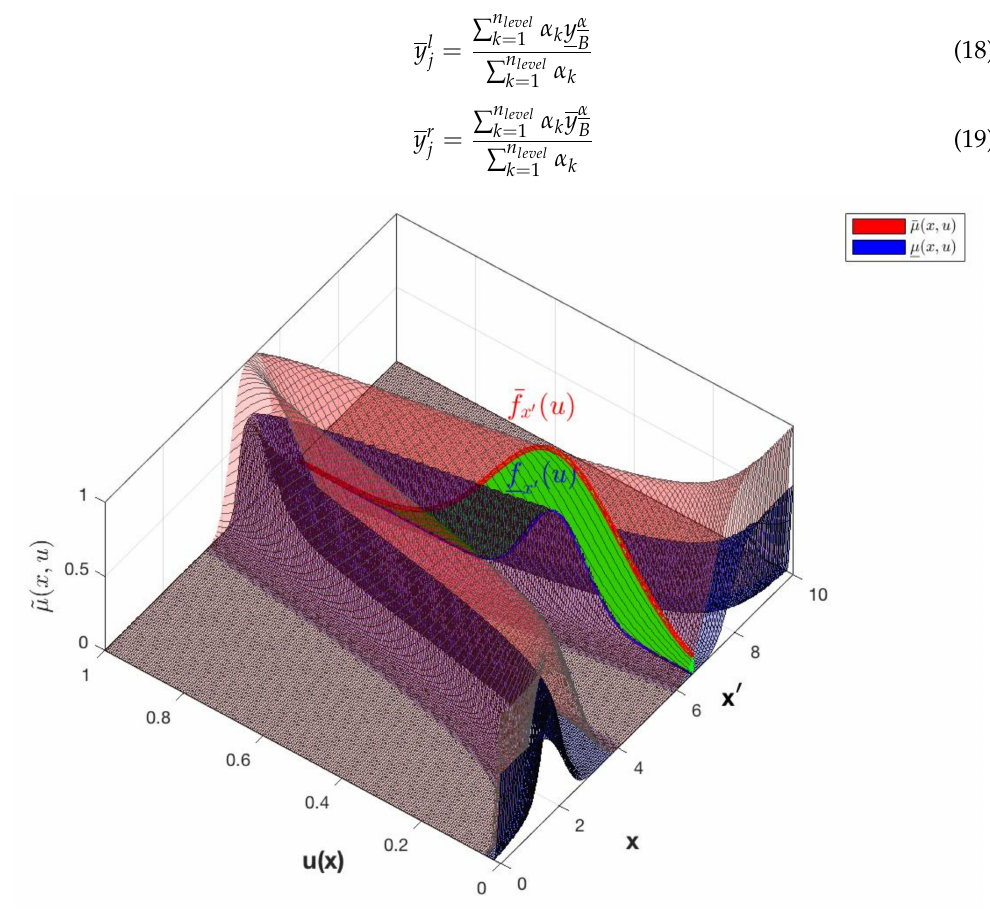
(cid:105) (cid:104) ( u ) , f ( u ) f x (cid:48) x (cid:48)